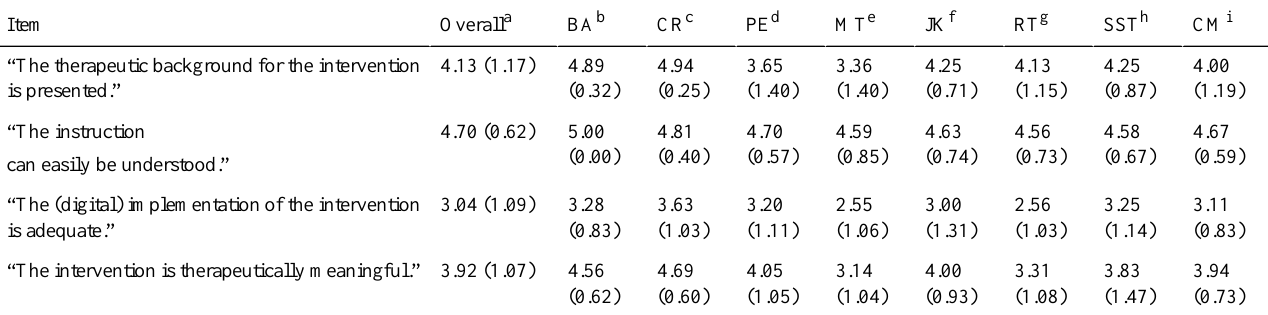
Table 3. Mean (SD) scores of assessments of the therapeutic quality in interventions of desktop programs.